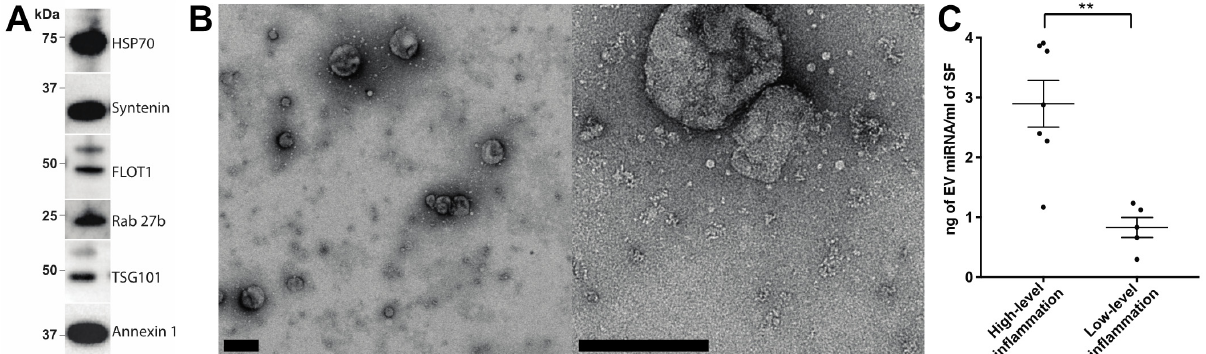
Figure 1. Assessment of synovial fluid EV enrichments prepared using size-exclusion chromatography. ( A ) Synovial fluid EV enrichments prepared by SEC were assessed for the presence of the canonical EV markers (HSP70, syntenin, FLOT1, Rab 27b, TSG101 and annexin 1) via Western blotting. ( B ) The quality of EV enrichments was further assessed by trans- mission electron microscopy (scale bars = 200 nm). ( C ) miRNA concentration per mL of rheumatoid arthritis synovial fluid in joints with high- or low-grade joint inflammation. Group means are indicated. Data analysed with Student’s i -test. Error bars = SEM. ** denotes p -value < 0.01.